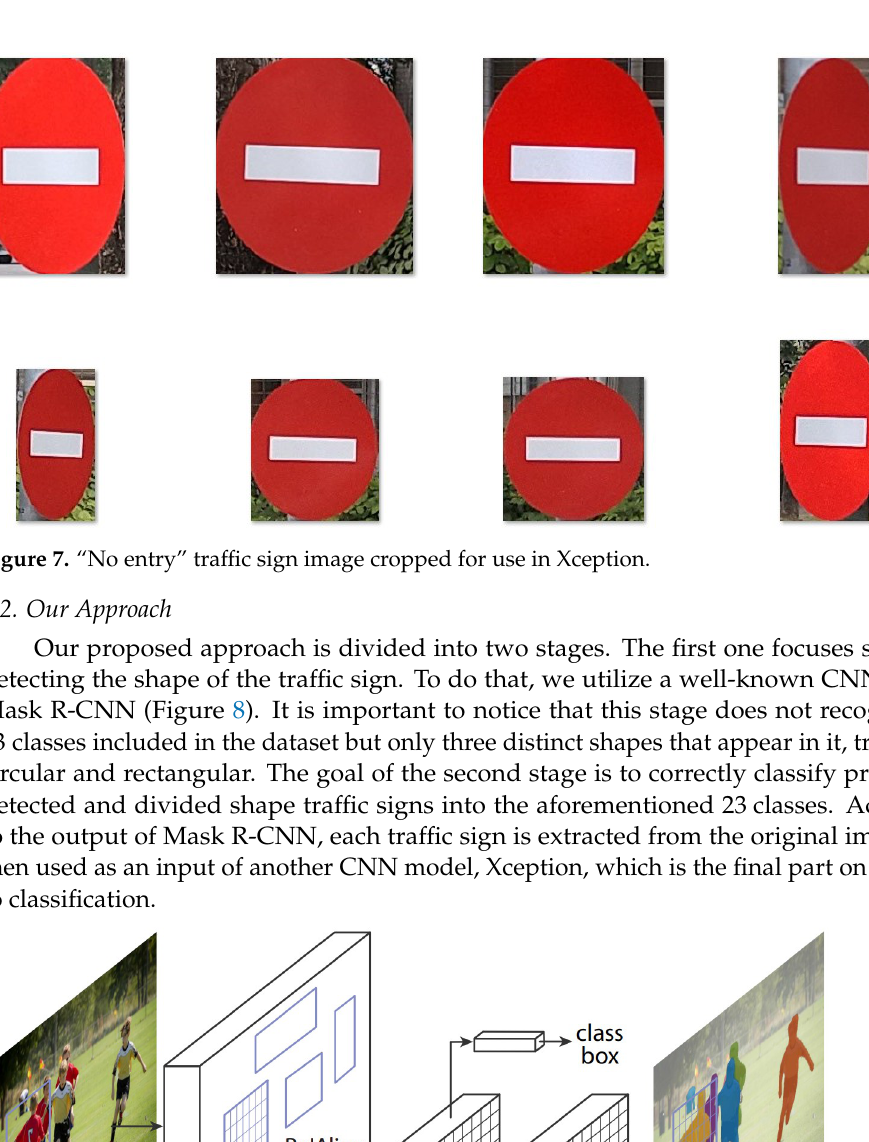
Figure 6. Dataset preparation using VGG annotating software.